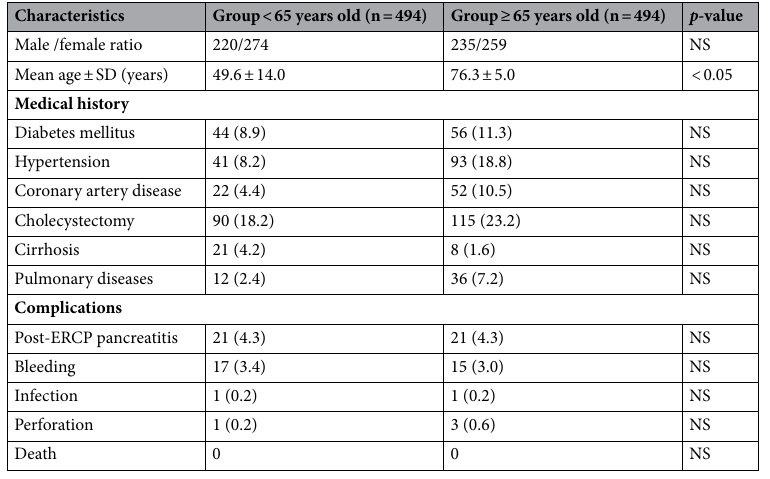
Table 1. Baseline characteristics, medical history, and ERCP complications in the group aged 65 below as compared with the elderly. Data are given as mean ± SD or n (%). NS: non-significant.